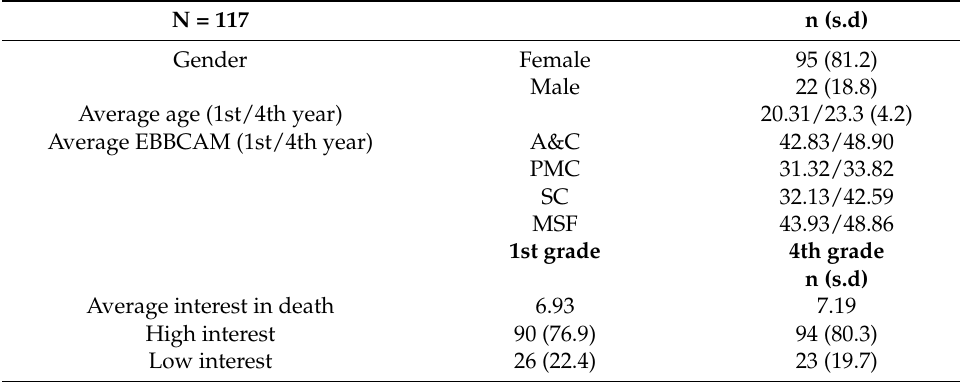
Table 2. Basic description of the sample.